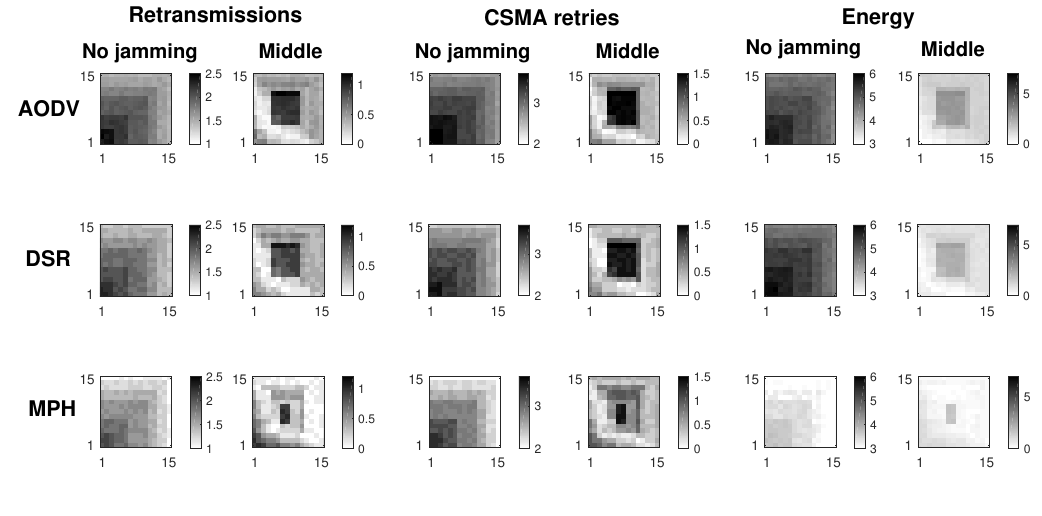
Figure 6. Network links with irregular